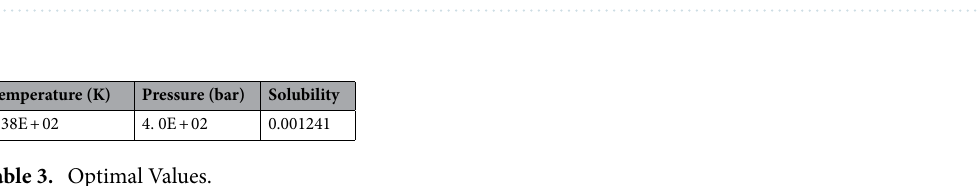
Figure 5. Trends for Temperature.